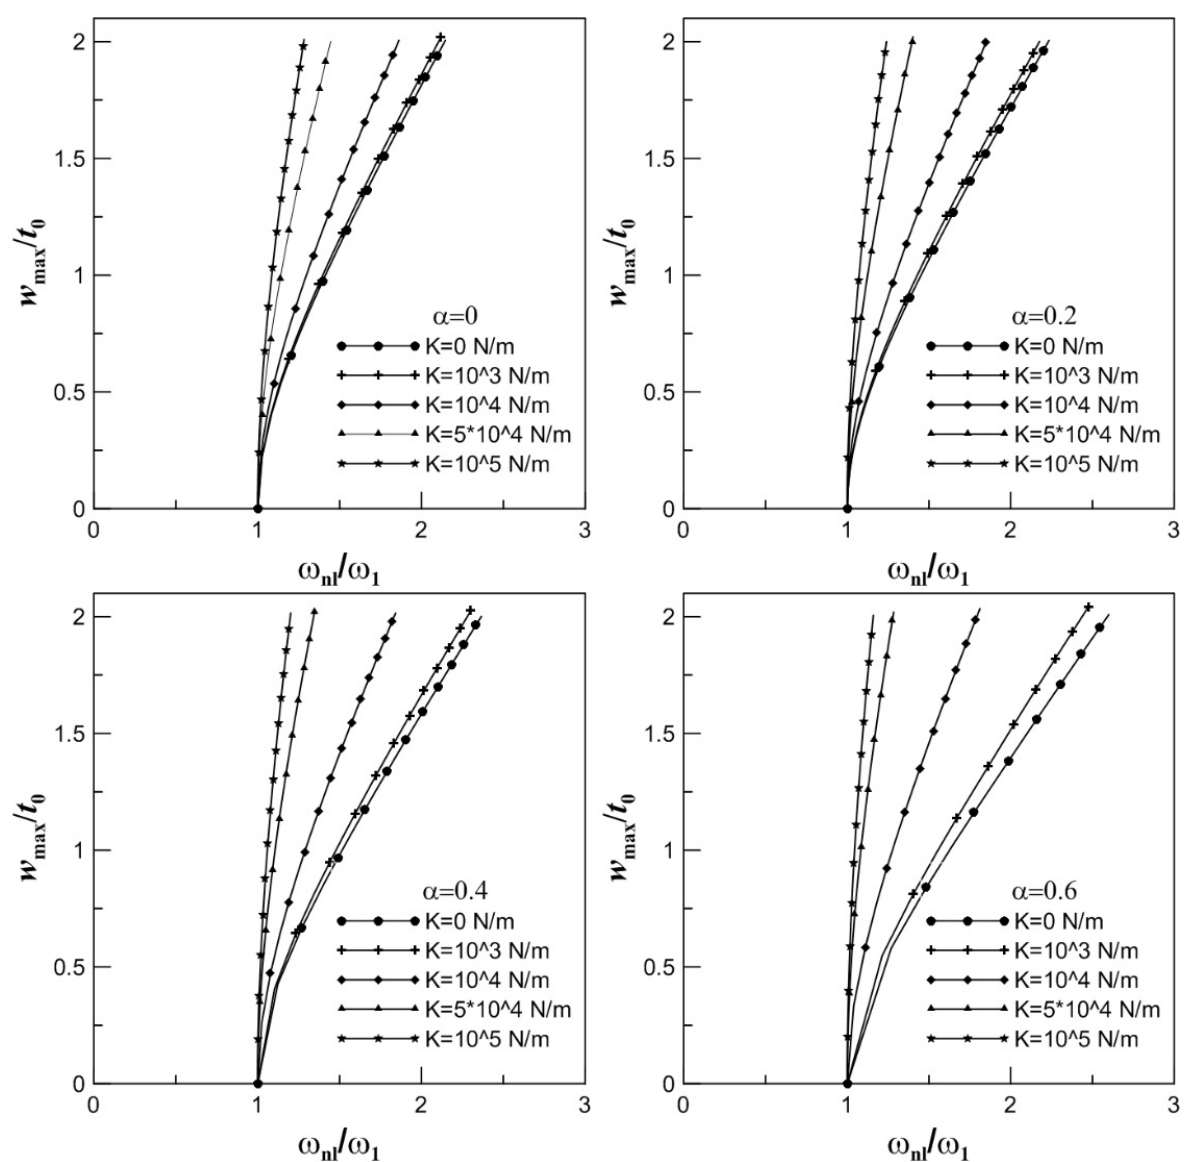
Figure 3: Backbone curve of AFG linear taper beam ( E ( ξ ) = E 0 , ρ ( ξ ) = ρ 0 ) on elastic foundation.